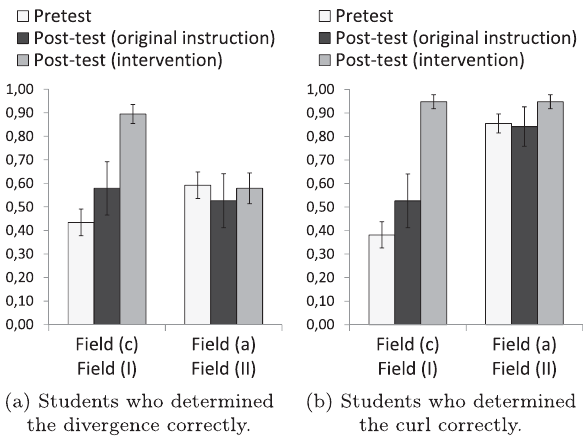
8. The proportion of KU Leuven students who determined correctly where the divergence or curl is nonzero in a field vector plot on the pretest [field (c) and (a) in Fig. 7] versus the post-test [field (I) and (II) in Fig. 7], after the original instruction ( N ¼ 19 ) and the intervention ( N ¼ 57 ). Only the students who took both the pre- and post-test are taken into